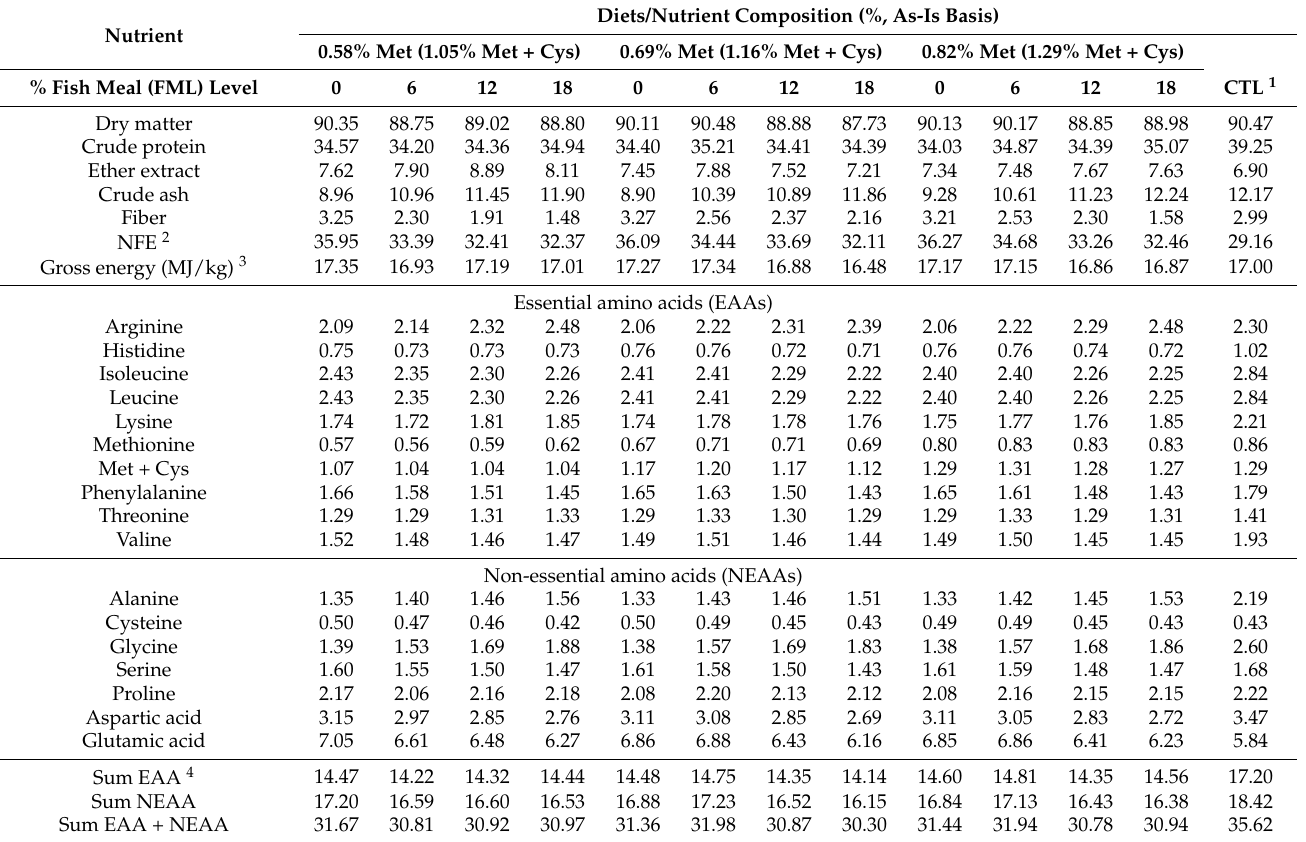
Table 2. Proximate and amino acid composition (% of the diet, as-is) of experimental diets to evaluate growth performance.